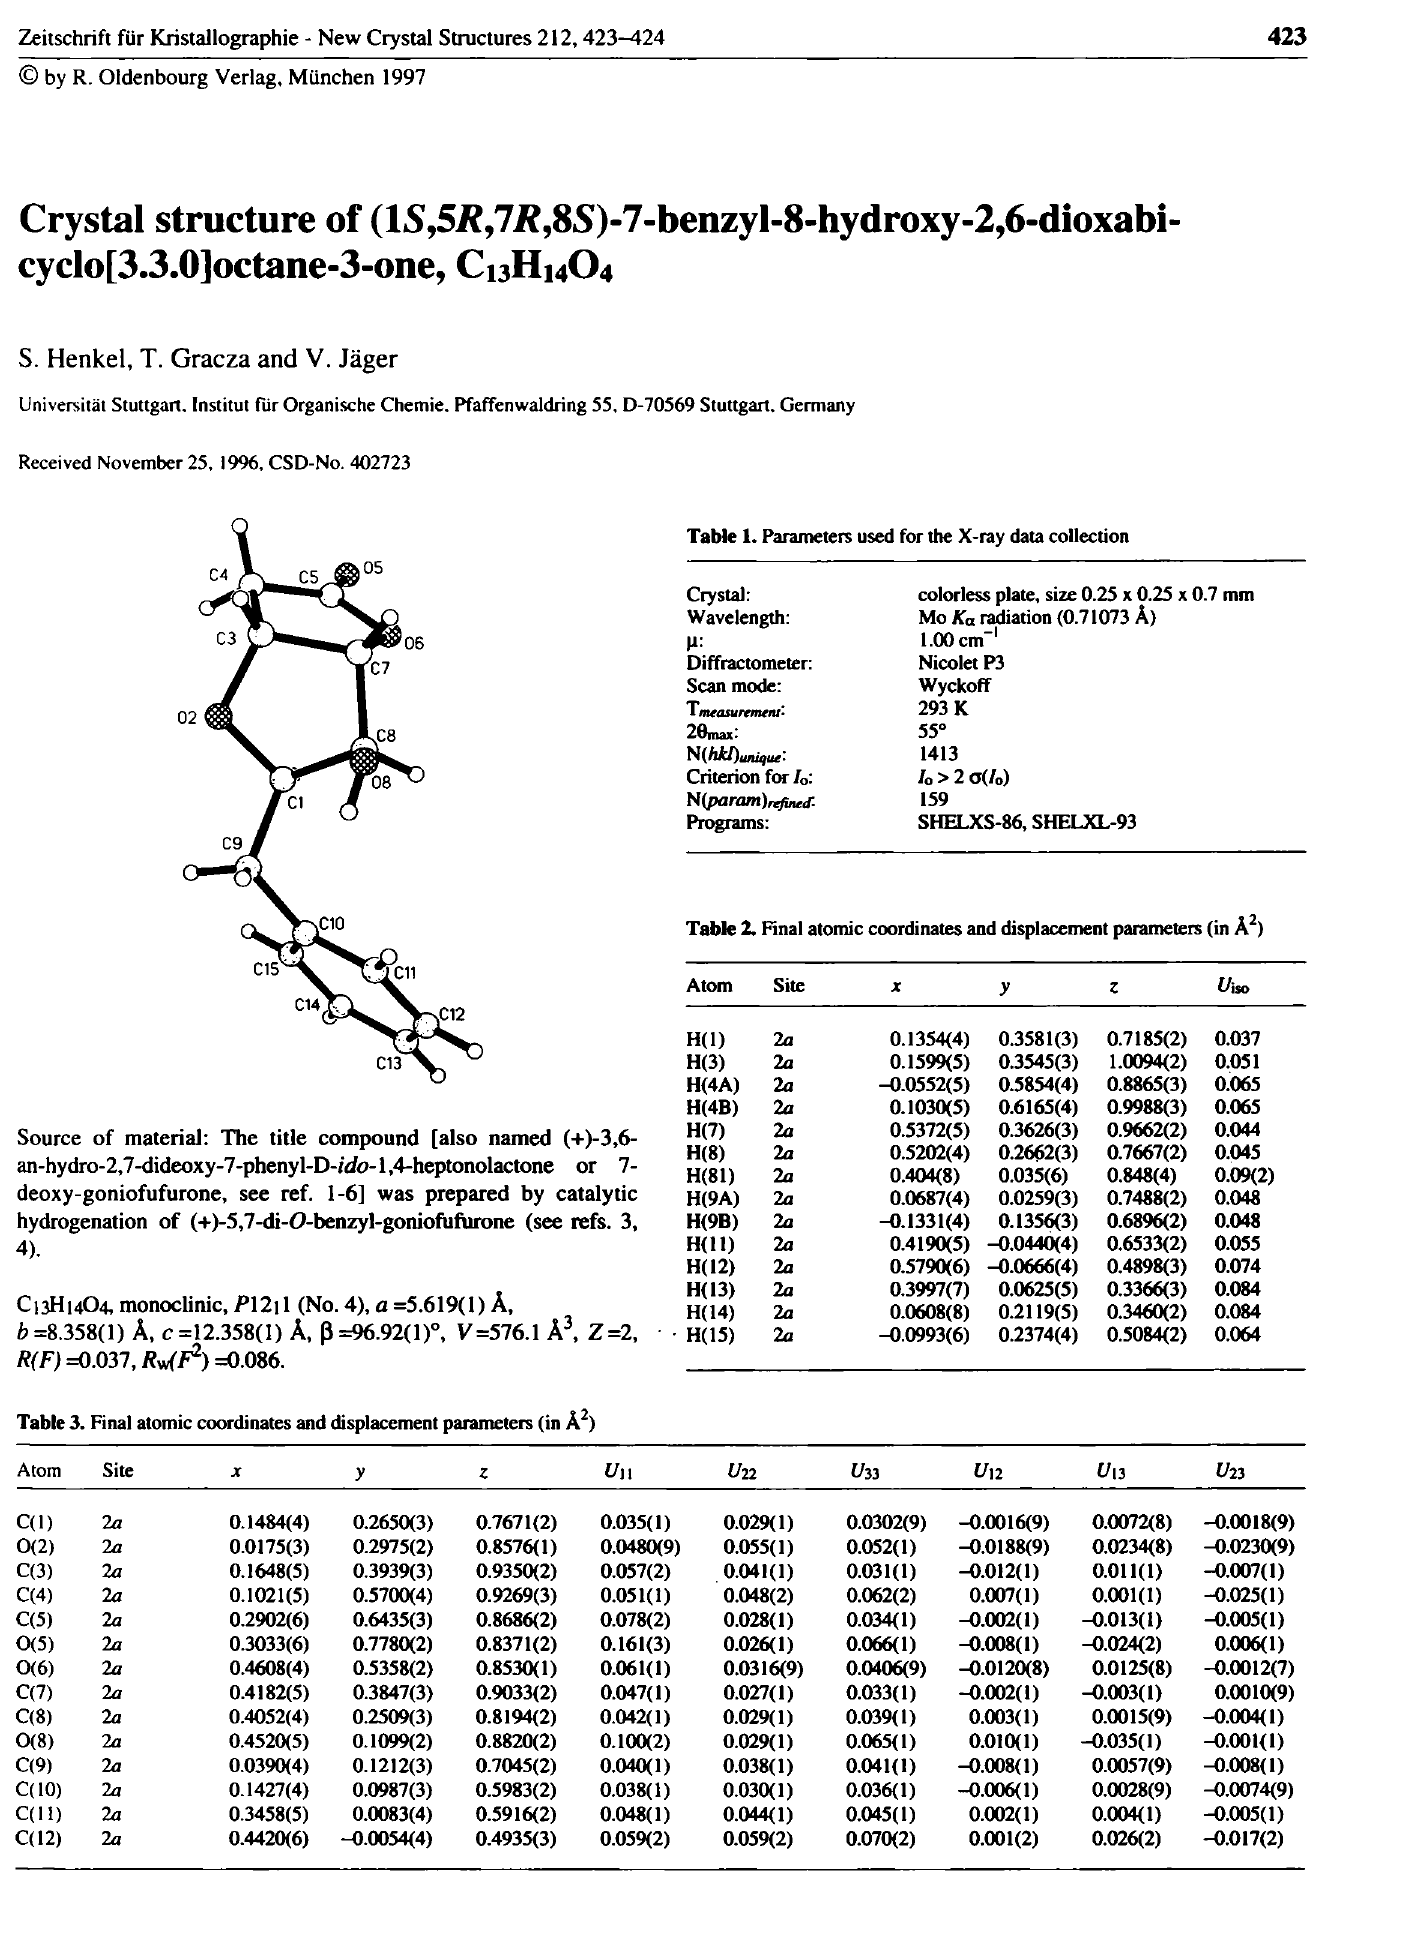
Table 1. Parameters used for the X-ray data collection